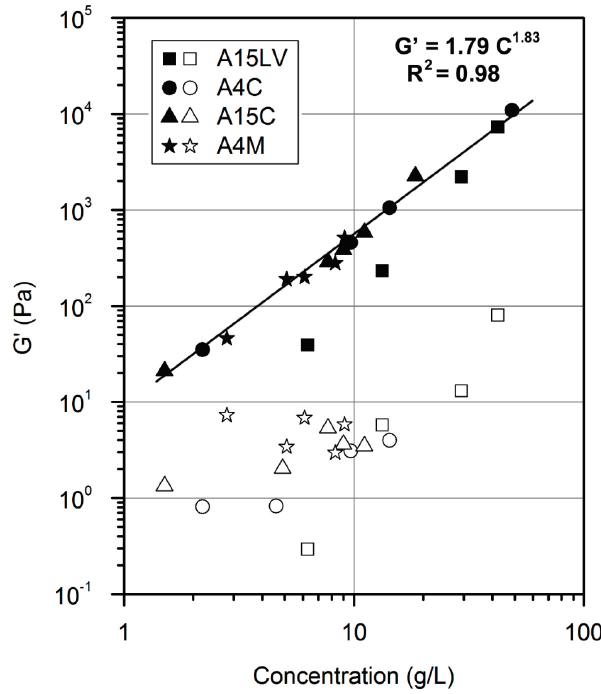
Figure 10. Storage moduli G ' as a function of the polymer concentration at 50 °C (open symbols) and 75 °C (filled symbols) and 0.5 Hz for A15LV ( M v = 42,000), A4C ( M v = 212,000), A15C ( M v = 304,600) and A4M ( M v = 423,400) aqueous solutions. Reproduced with permission from Taylor & Francis Group, 2015